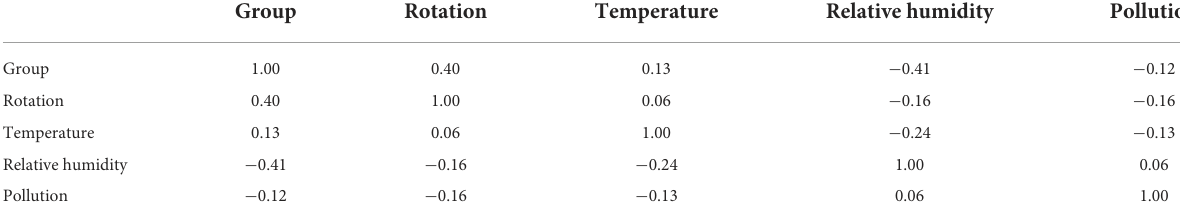
TABLE 5 Pearson’s correlation coefficient among variables.